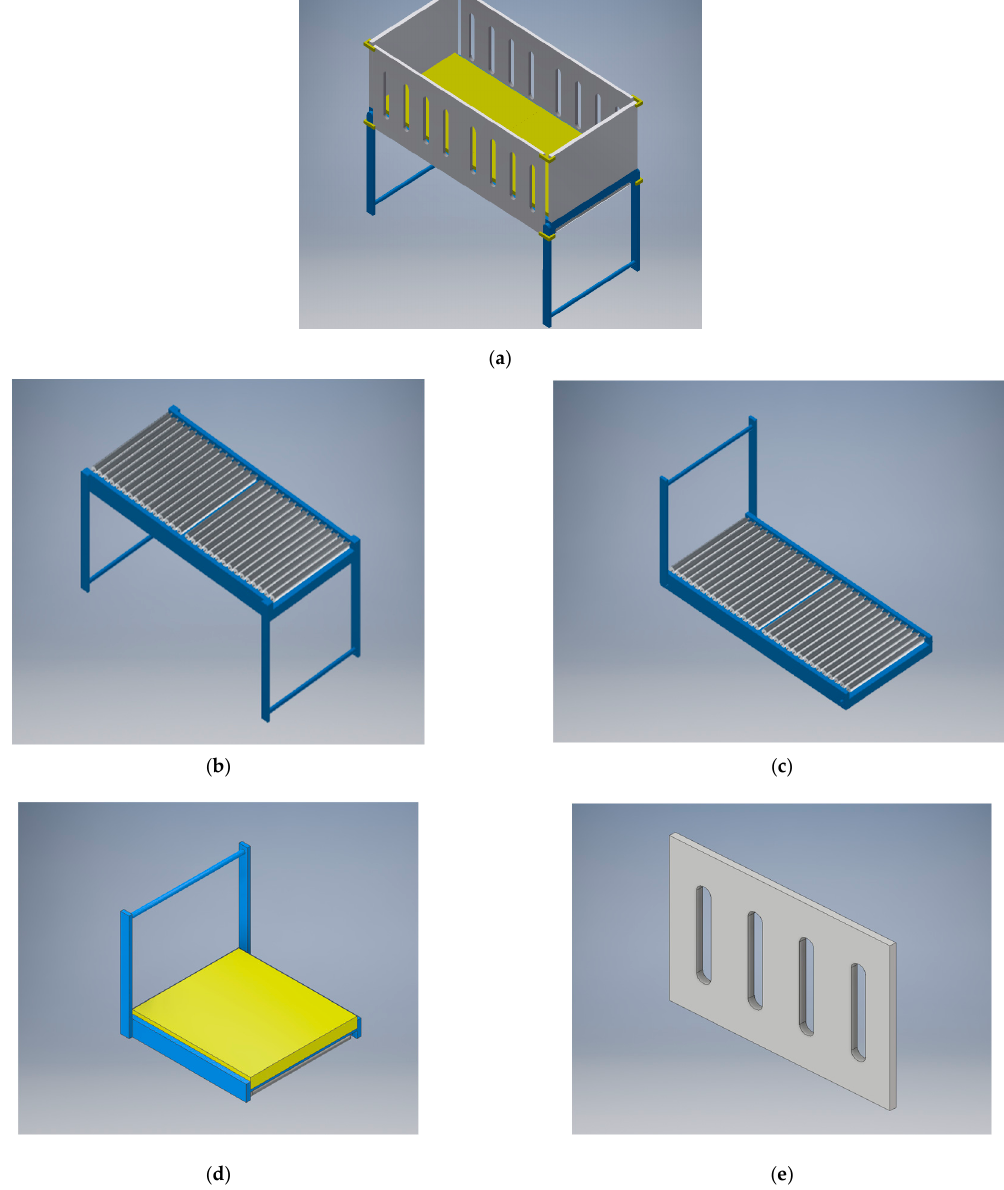
Figure 6. Repurposed parts of concept 5. ( a ) Crib design. ( b ) Conveyer belt design. ( c ) Treadmill design. ( d ) Pushcart design. ( e ) Bicycle stand design.